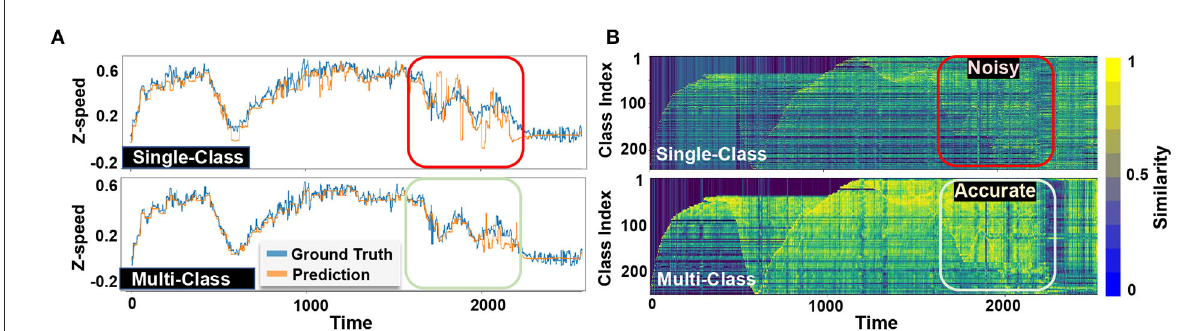
FIGURE6 Visualization of classification results of EventHD prediction on single-class and multi-class update configurations for z-axis linear speed of MVSEC outdoor night 1: The model is trained on the first 1,000 ground truth samples and then used to predict up to 2,500 samples as indicated by the time axis. (A) Visualize EventHD final prediction for linear speed along z-axis compoared to ground truth and (B) Display the similarity between the query and each class hypervectors.